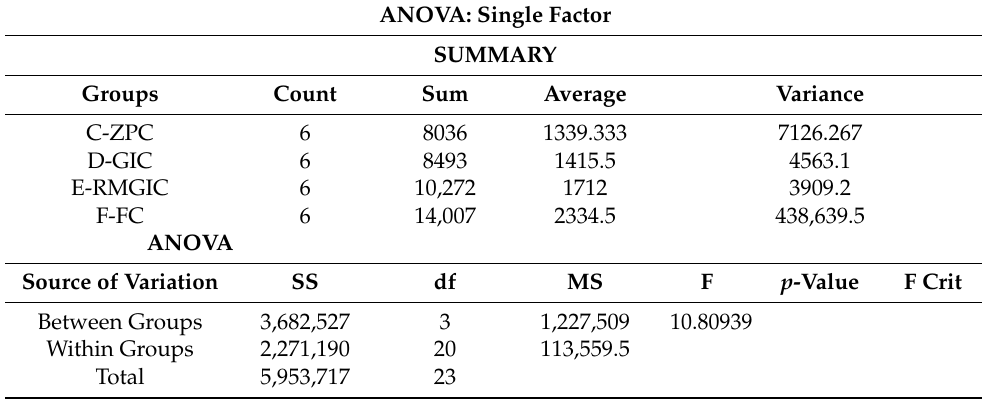
Table 4. ANOVA Method and p